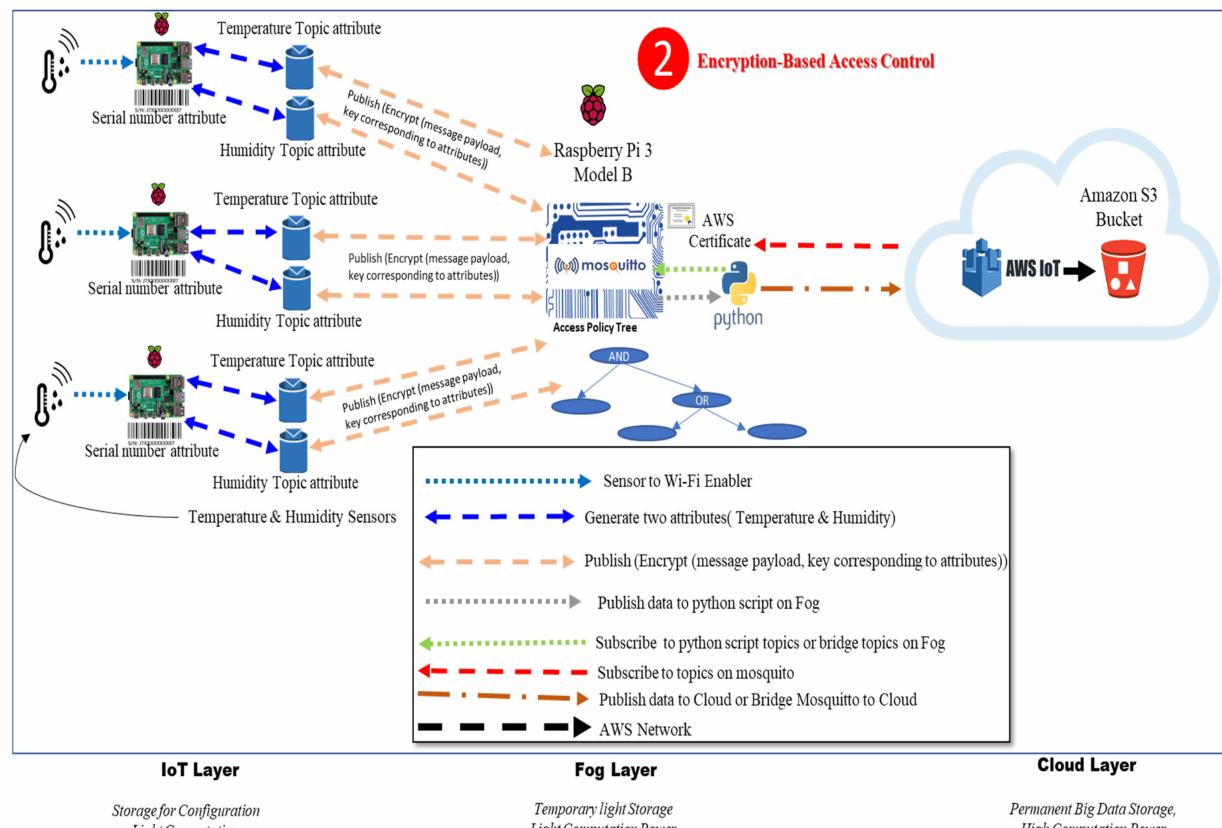
Figure 5. Access control model applied to the IoT–Fog–Cloud